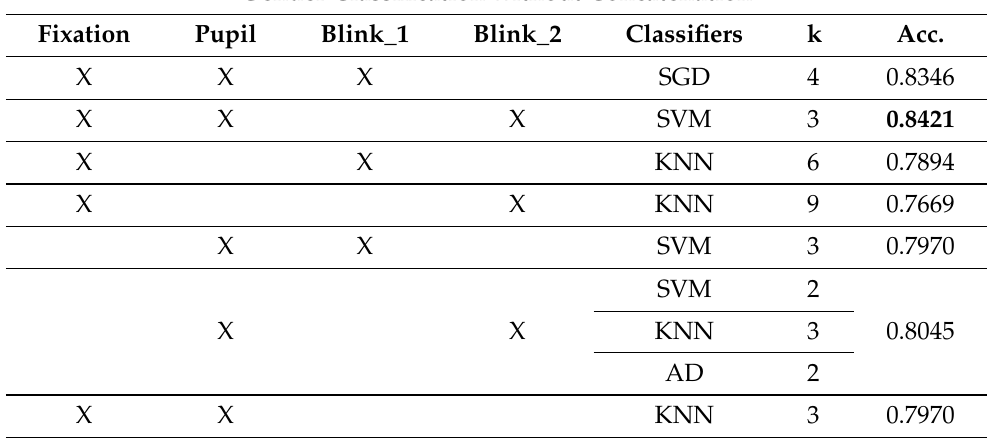
Table 5. The results of the gender classification are obtained from combination of the best scores of the three biometric traits. For blinks, as maximum accuracy is achieved with two different classifiers, both scores are taken into account. For “Blink_1” we refer to the scores related to the DT classifier, while for “Blink_2” to those related to the BG classifier. k is the value of the implemented k-fold cross-validation strategy relating to the best accuracy achieved. The numbers in bold are the best results. X indicates the features selected for experimentation.